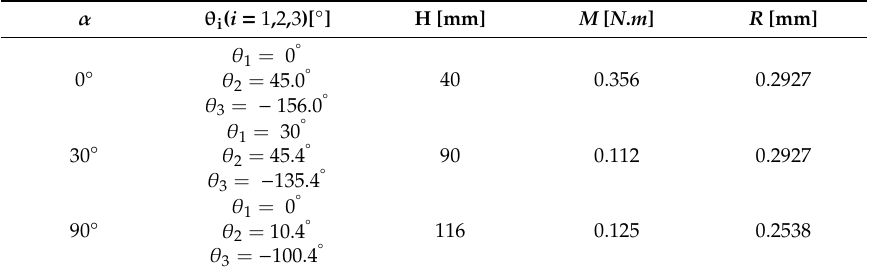
Table 5. Low-energy static postures of robot under di ff erent values of α .